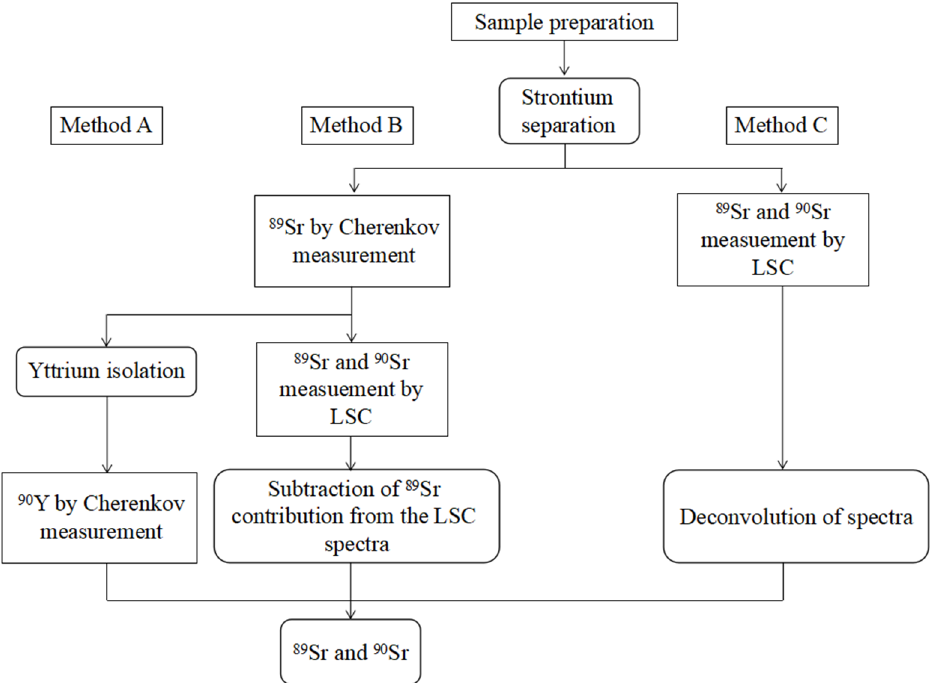
Figure 3. Comparison of different strategies for measurement of 89 Sr and 90 Sr. Second chemical separation (Method A), spectrum subtraction (Method B) and spectrum deconvolution (Method C). Reprinted with permission from Ref. [119]. 2018, Stina Holmgren Rondahl.